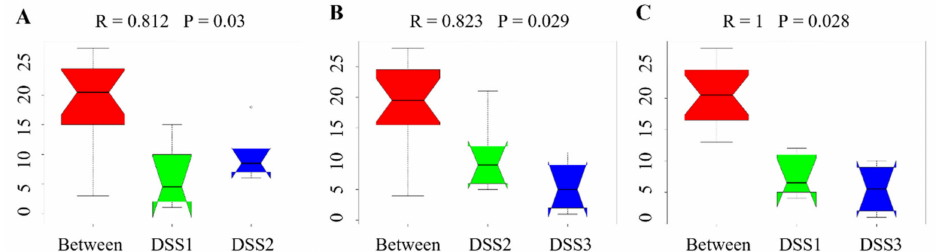
Figure 9. Anosim analysis results within the DSS group. ( A ) day 1 vs day 7; ( B ) day 7 vs day 13; ( C ) day 1 vs day 13. R-value close to 1 shows that intra-group similarities are greater than inter-group similarities. „Between” represents the difference between groups; the greater distance shows the greater difference, and the thickness represents the sample size. Numbers next to the group name represent time-points of faecal samples collection: 1, before induction of colitis (day 1); 2, at the end of DSS administration (day 7); 3, at the end of experiment (day 13). DSS, induced